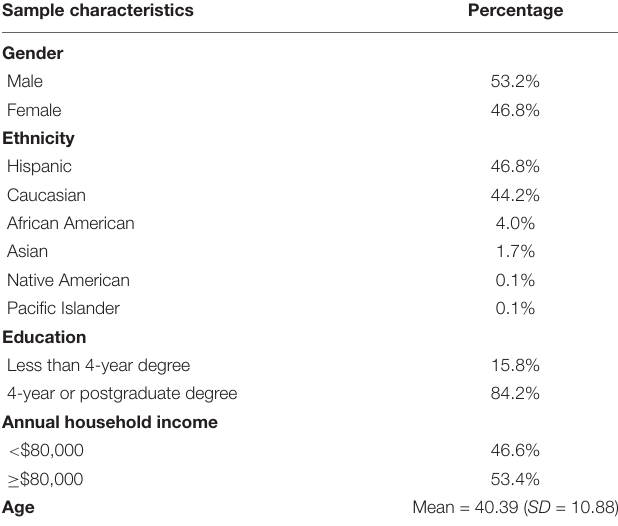
TABLE 1 | Sample characteristics.